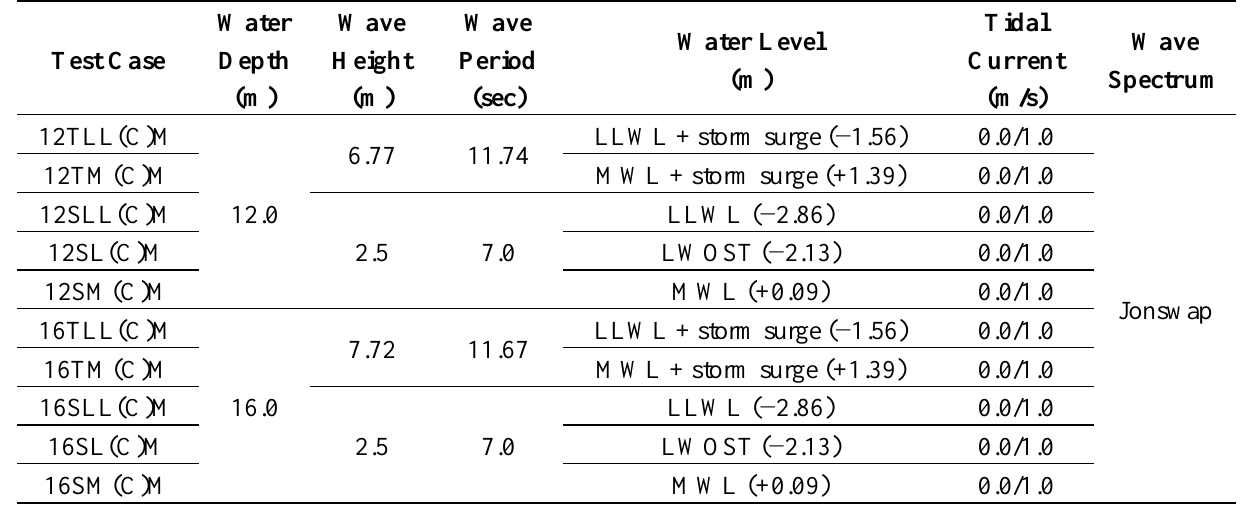
Table 1. Test conditions of the mobile bed